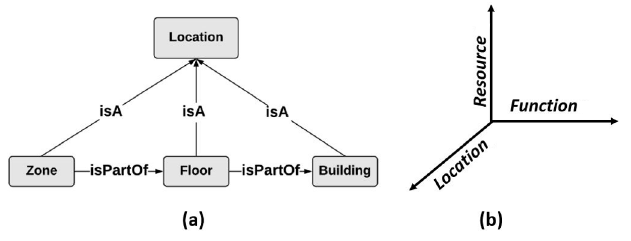
Figure 4. An example of a geographic hierarchy VS The indexing